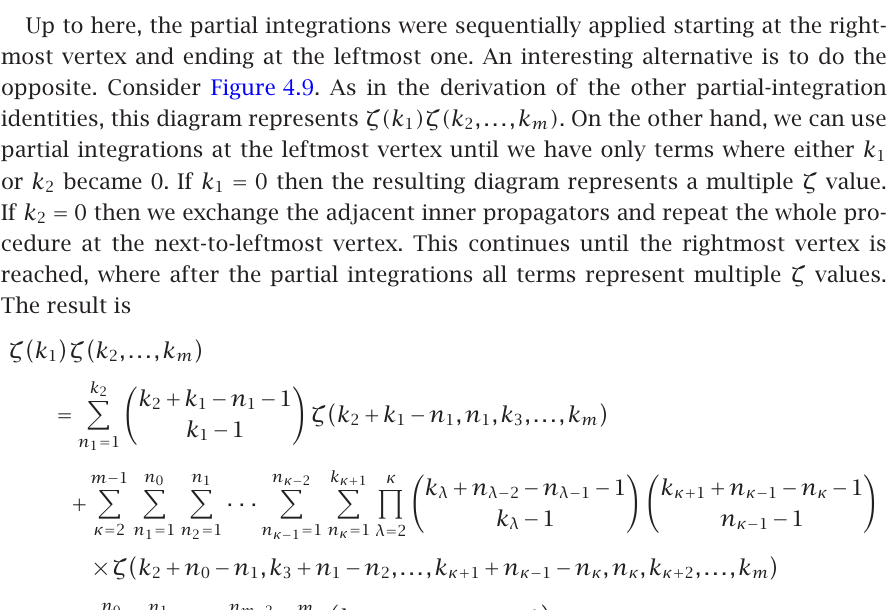
Figure 4.9 . Modified sea shell